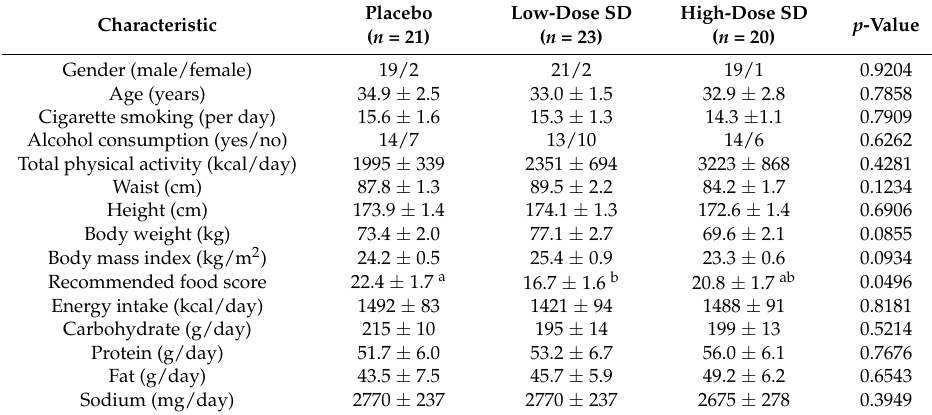
Figure 1. CONSORT diagram of the study. The flow of subjects from enrollment to data analysis is shown, together with significant reasons for exclusion. All subjects who completed the study were analyzed. CONSORT, Consolidated Standards of Reporting Trials. Table 1. General characteristics of the participants 1 .